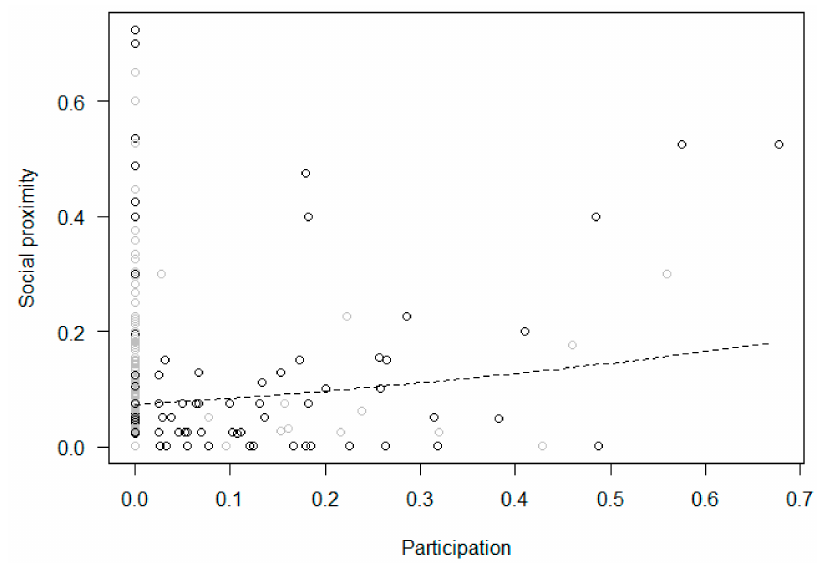
Figure 8. Social proximity (i.e., proportion of scans an individual was in social proximity, out of the total number of scans in which the subject was visible) as a function of participation (i.e., proportion of scans an individual interacted with the enrichment device in an enrichment session) during the treatment phase. Circles represent individual responses in each enrichment session in the morning (in black) and afternoon (in grey). The dashed line represents the fitted model, which is like Model 7b but unconditional on all the other predictors that were